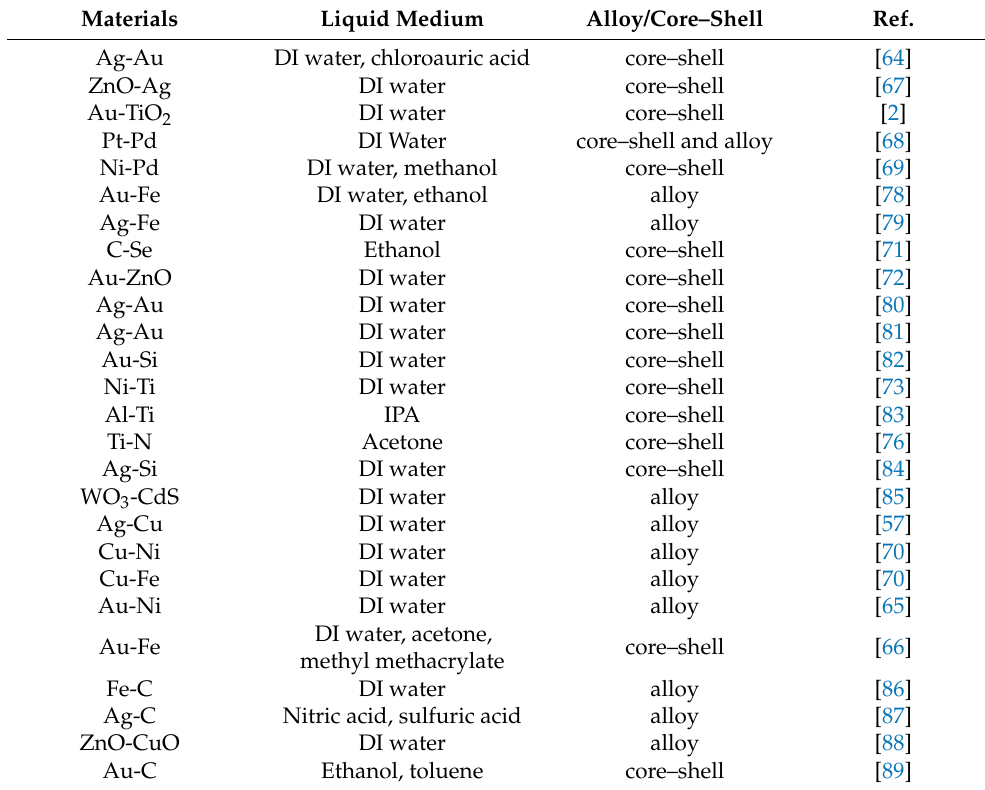
Table 1. Various types of bimetallic and composite nanoparticles are synthesised via pulsed laser ablation in